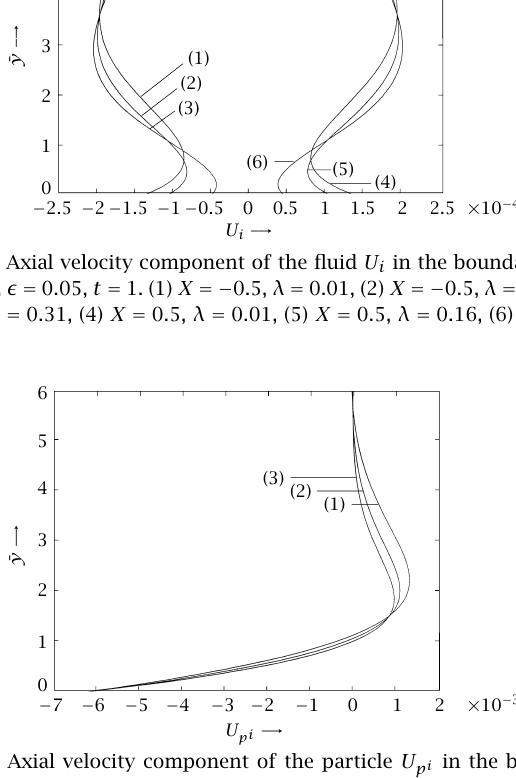
Figure 4.9 . Axial velocity component of the particle U layer for R = 500, 4 = 0 . 05, t = 2. (1) X = 0 . 5, λ = 0 . 01, (2) X = 0 . 5, λ = 0 . 36, (3) X = 0 . 5, λ = 0 . 71.